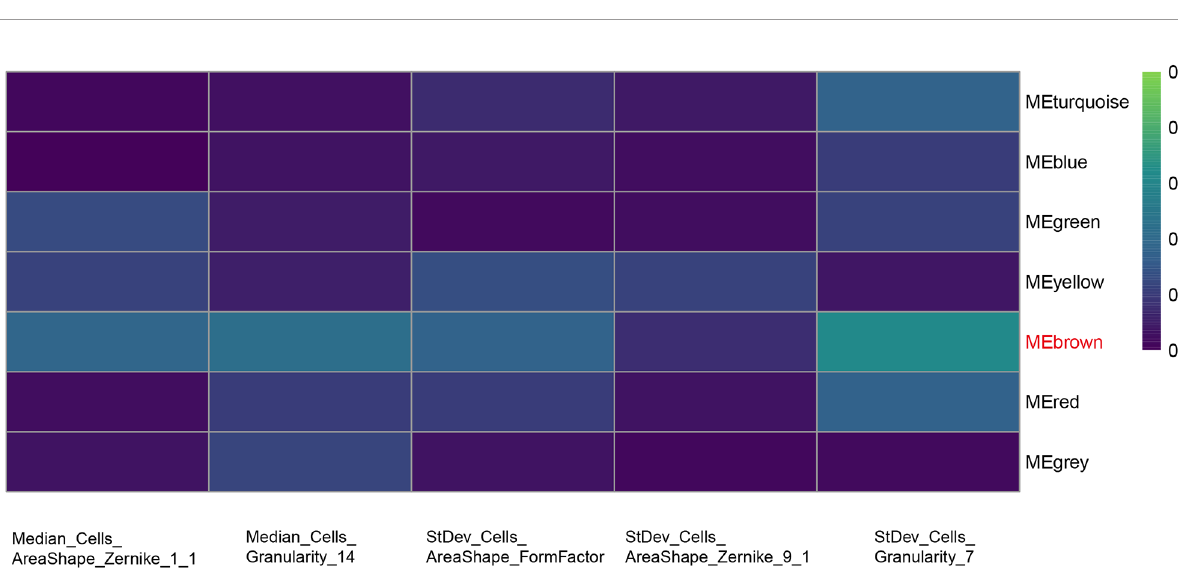
FIGURE 4 | Selection of the co-expression gene module related with the prognostic features. Heat map of the relationship between the fi ve prognosis-related features and co-expression gene modules by WGCNA. Brown module shows the most outstanding correlation with the imaging